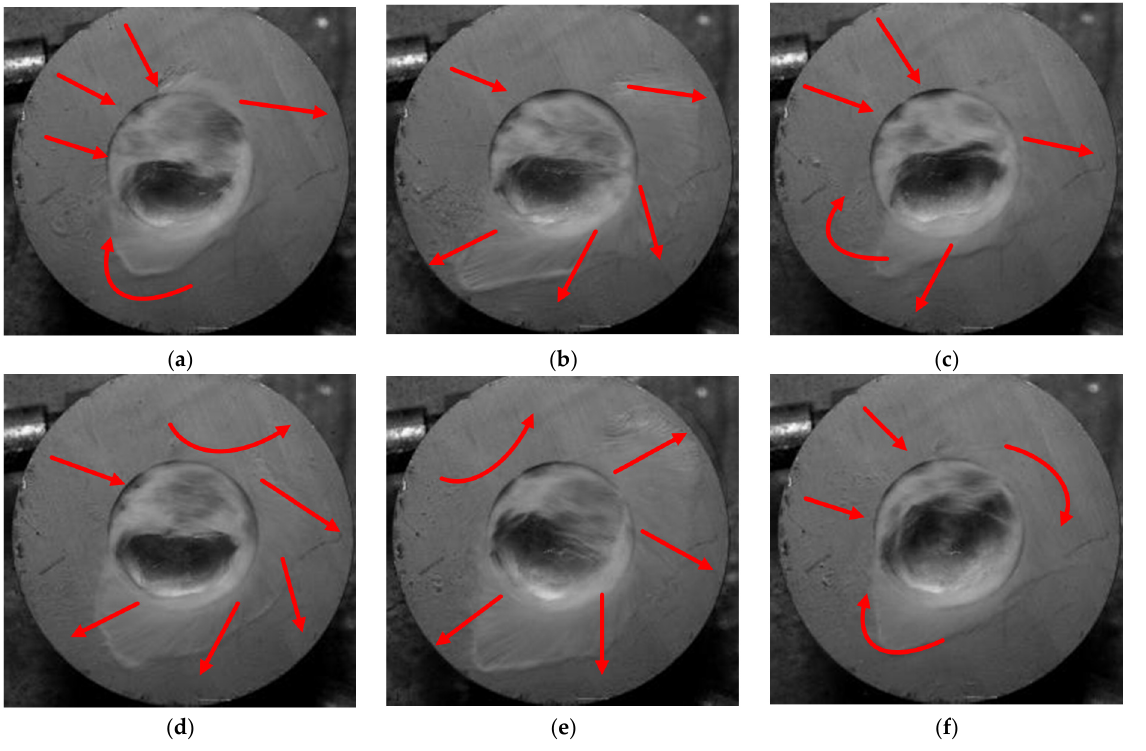
Figure 32. When inlet pressure = 15 MPa, gap = 1.5 mm, the photos of radial and axial fluctuations of fluid flow of the original suction cup at time ( a ) 5 ms, ( b ) 9.3 ms, ( c ) 13.6 ms, ( d ) 17.9 ms, ( e ) 22.2 ms, and ( f ) 26 ms. (The red arrows indicate the flow direction of fluid).